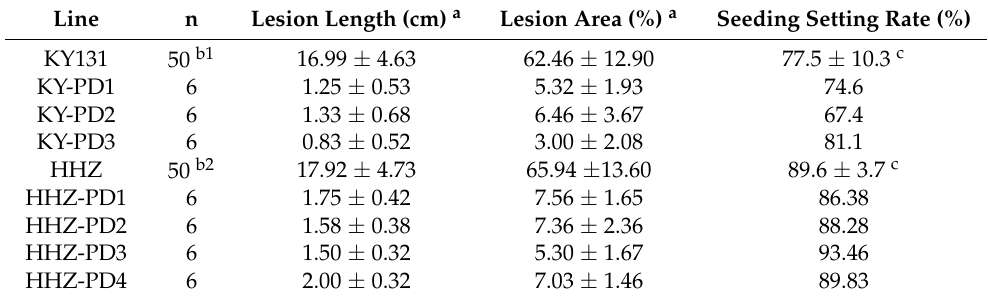
Table 3. Disease resistance and agronomic traits of T 0 generation KY-PD1-3 and HHZ-PD1-4 plants.